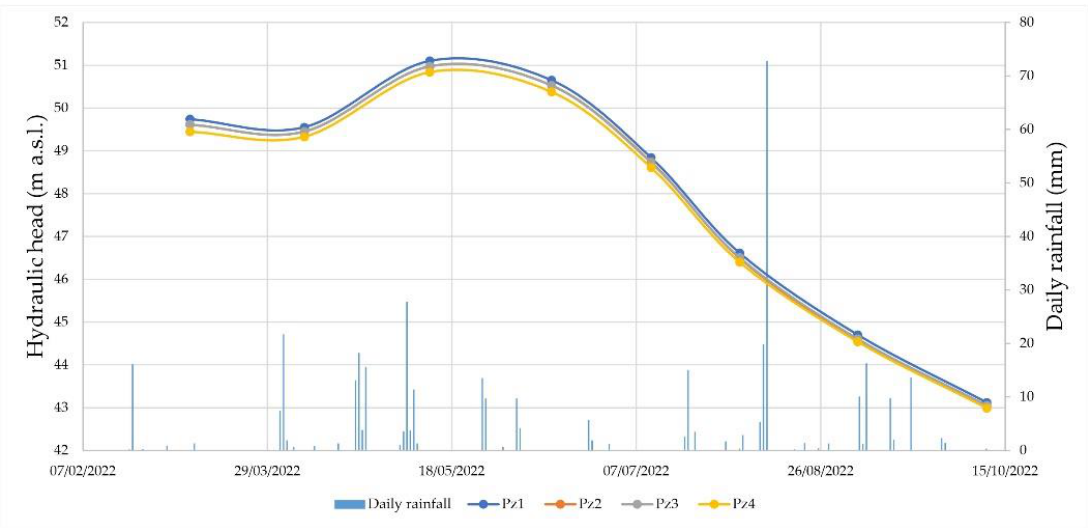
Figure 6. Hydraulic head fluctuations vs. daily rainfall (dates are given in day/month/year).